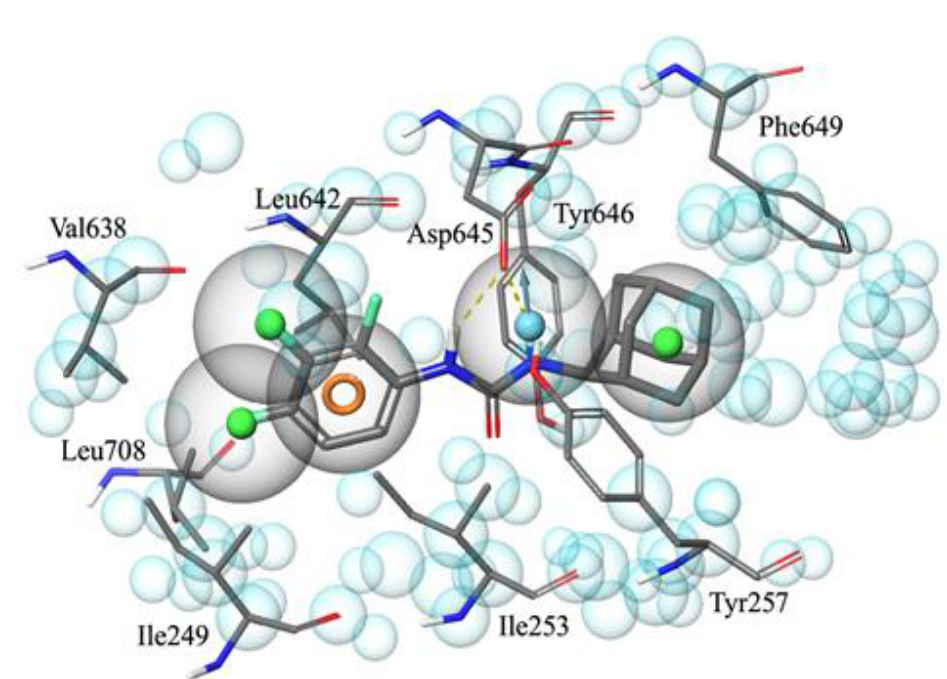
Figure 2. Graphical representation of the final five-feature pharmacophoric model for MmpL3 inhibitors embedded within the binding site that contains AU1235. Amino acids are represented by thin lines (atom type notation), while the inhibitor is rendered by thick lines (atom type notation). Green spheres represent the hydrophobic features of the pharmacophore, the orange circle is the aromatic ring, while the cyan sphere corresponds to the hydrogen bond acceptor feature. Light cyan spheres of variable size represent excluded volumes. Hydrogen bonds between the amidic NH groups of the inhibitor and Asp645 side chain are coded by dashed yellow lines.